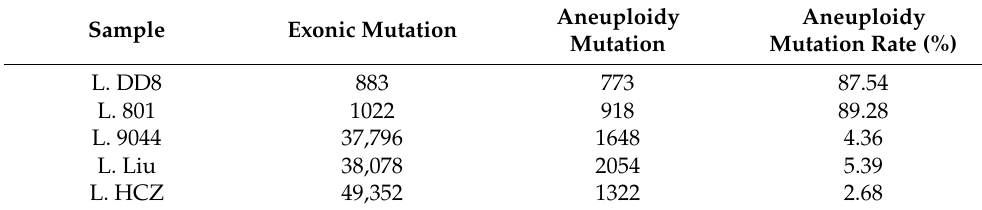
Table 4. Exonic mutation in five Leishmania isolates.